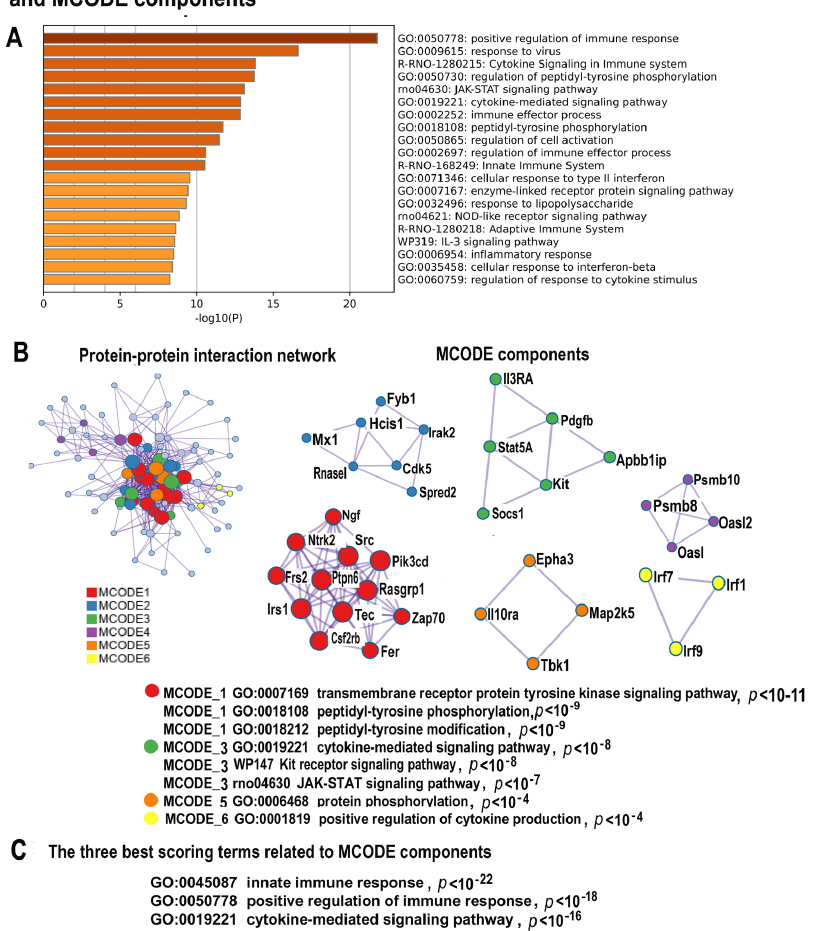
Figure 5. The enrichment of NLI-induced genes related to the cluster “Immunity” in gene pathways, processes, and molecular complexes. ( A )—Bar graph of enriched terms related to gene pathways and processes across the gene cluster related to immunity. The statistical significance of enrichment is shown in X -axis ( − log10( p )). ( B )—Protein–protein interaction network and MCODE complexes that were identified in the gene list. The network and MCODE components were constructed on the base of physical interactions taken from the String server (physical score > 0.4). The coding by color square reflects the MCODE components. The coding by color circles indicates the results of MCODE component pathway and process enrichment analysis. ( C )—The three best-scoring terms related to